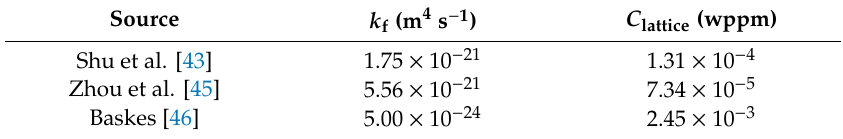
Table 3. Recombination coefficient and lattice H concentration calculated with different sources.